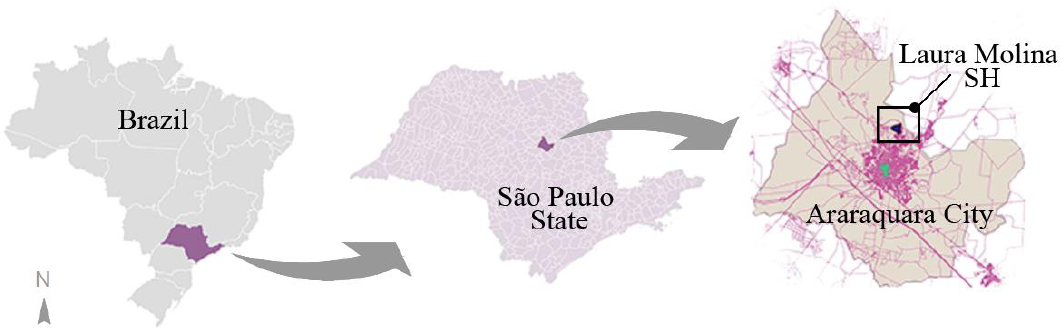
Figure 1. Araraquara and Laura Molina SH location. Source—Adapted from [20–22,25].